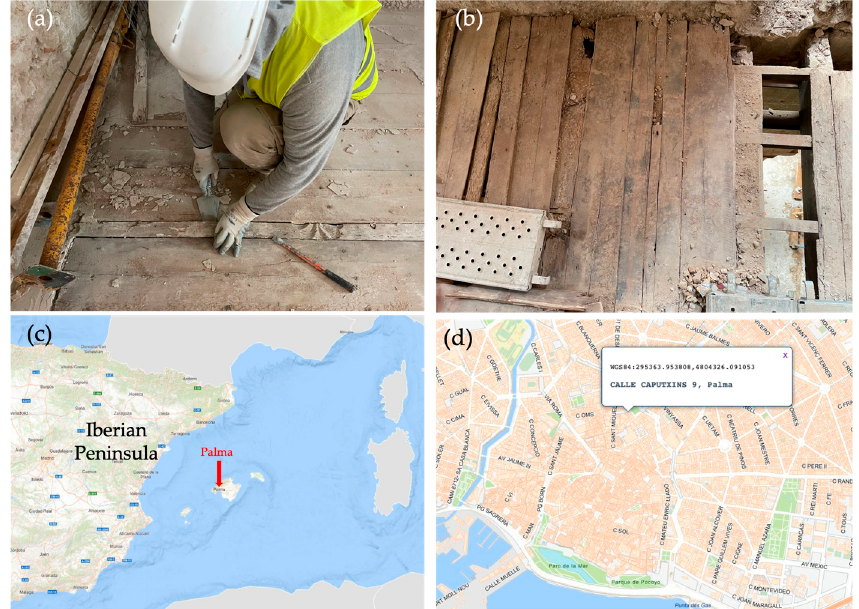
Figure 1. ( a , b ) Photographs of the casal that shows how the reused panels of the Hispano-Muslim alfarje were found; ( c ) map of Balearic Islands; (https://centrodedescargas.cnig.es/CentroDescargas/index.jsp) (Accessed on 23 January 2023); ( d ) map of the center of Palma de Mallorca (https://centrodedescargas.cnig.es/CentroDescargas/index.jsp) (Accessed on 23 January 2023) the green square marks the area where the casal is located.